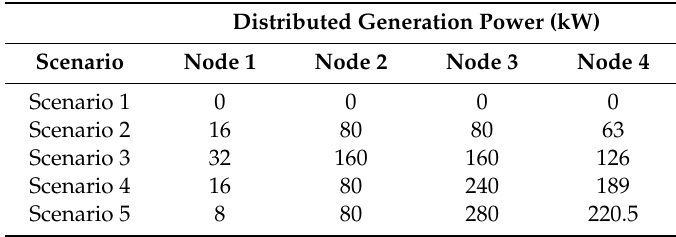
Table 6. Distributed generation active powers in the di ff erent scenarios under